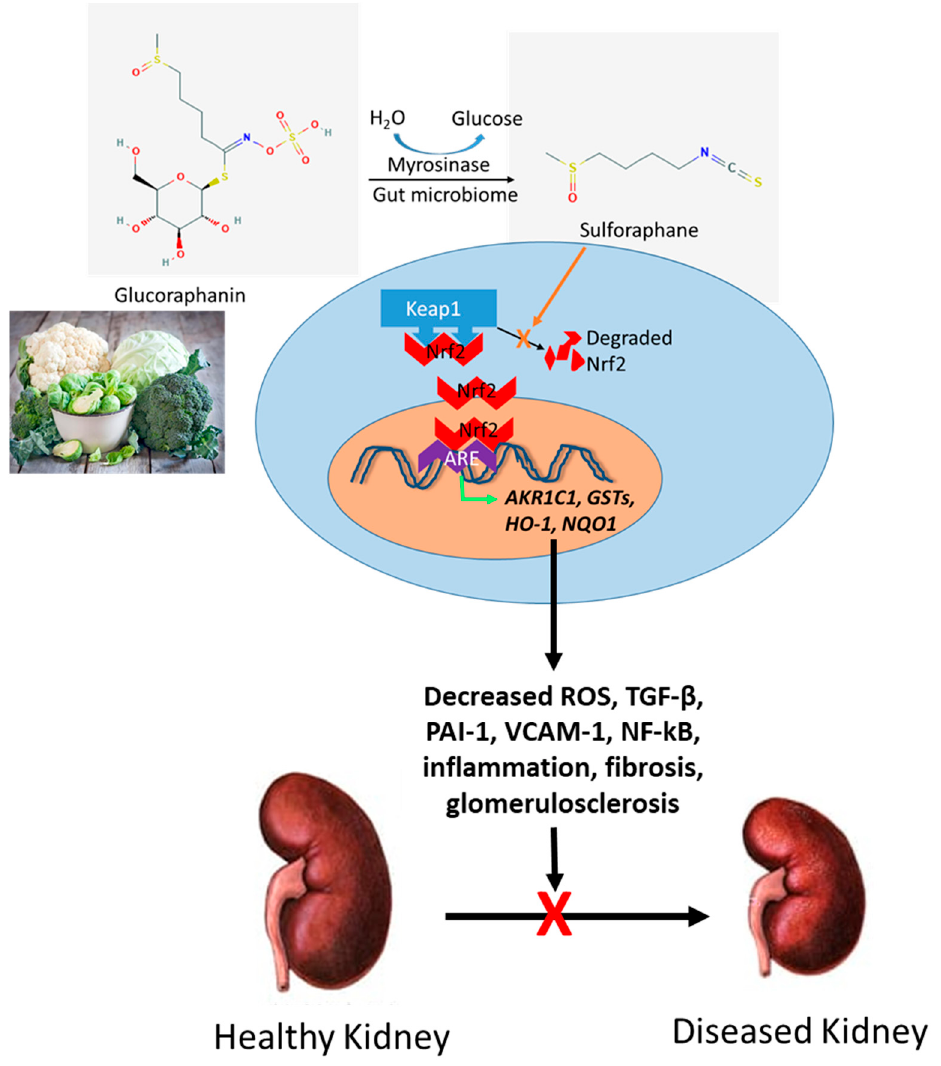
Figure 2. Sulforaphane targets Nrf2 pathway to prevent kidney disease progression. Glucoraphanin in cruciferous vegetables is hydrolyzed to sulforaphane by the enzyme myrosinase or by the gut microbiome. Sulforaphane inhibits the KEAP-1-mediated degradation of Nrf2, allowing Nrf2 to migrate from the cell cytoplasm into the nucleus where it binds to the antioxidant responsive element (ARE) in the promoter regions of Nrf2 target genes, thereby increasing their transcription, and hence their activities. The result is a decrease in ROS and factors involved in inflammation and fibrosis. Image of cruciferous vegetables taken from https://www.eatright.org/food/vitamins ‐ and ‐ supplements/nutrient ‐ rich ‐ foods/the ‐ beginners ‐ guide ‐ to ‐ cruciferous ‐ vegetables. Image of healthy and diseased kidney taken from